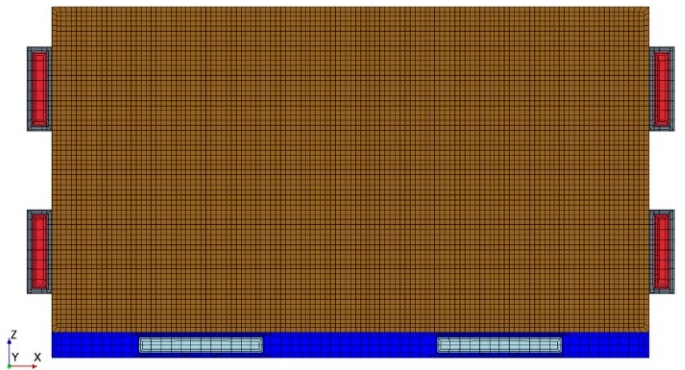
Figure 6. Configuration of a typical numerical grid in the numerical domain.